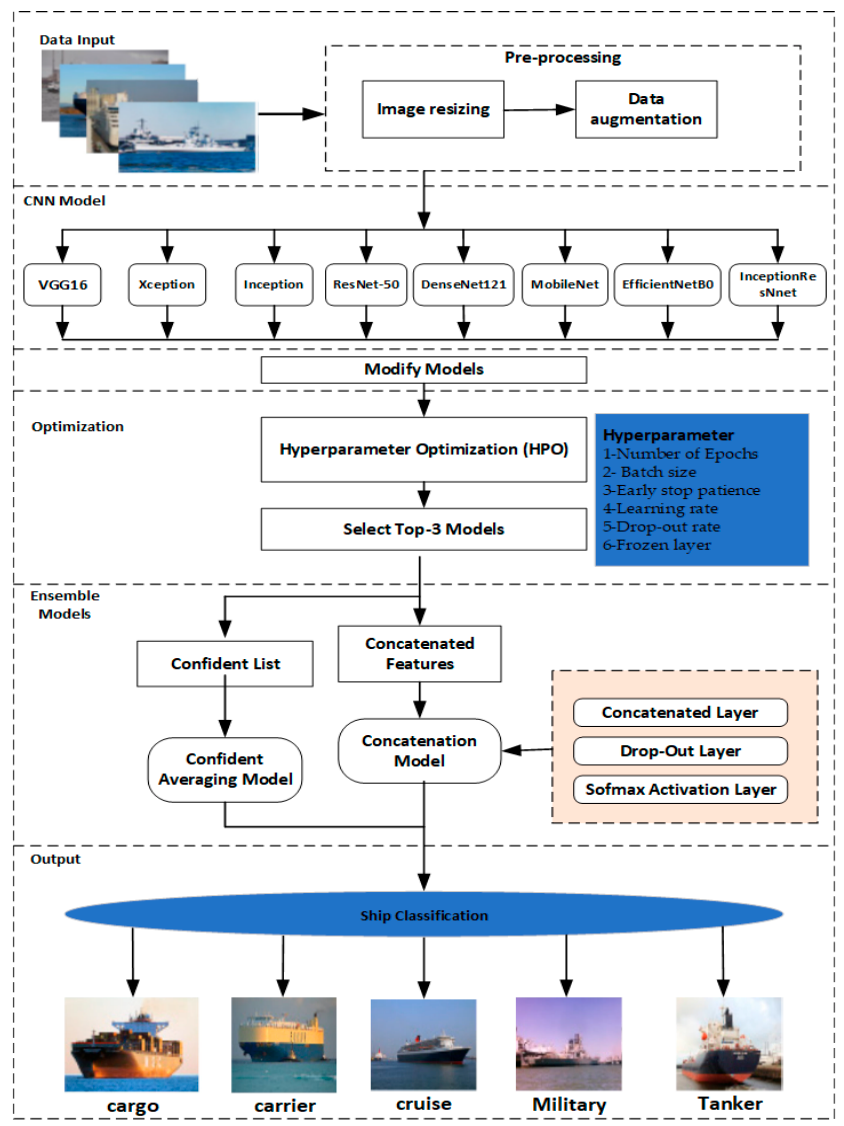
Figure 1. Proposed architecture of modified ensemble